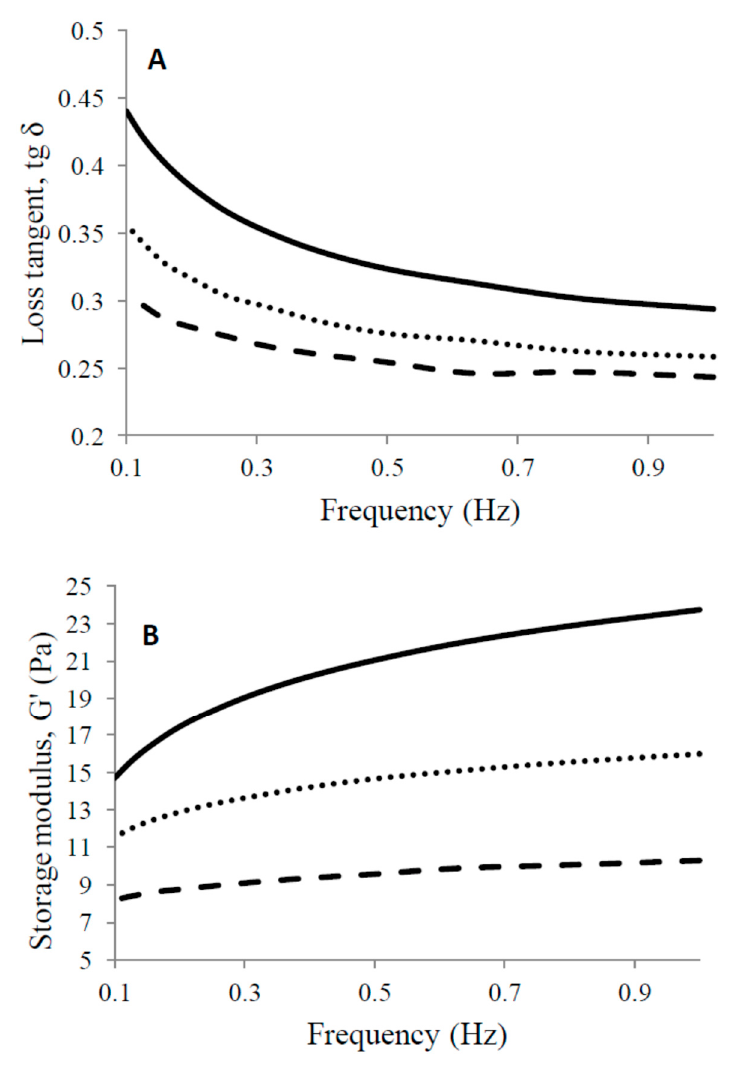
Figure 2. Storage moduli (G’) ( A ) and tg ( δ ) ( B ) of rennet gels from milk heated to 65 °C/30 min ( ), 80 °C/5 min ( ) and 90 °C/5 min ( ) as a function of